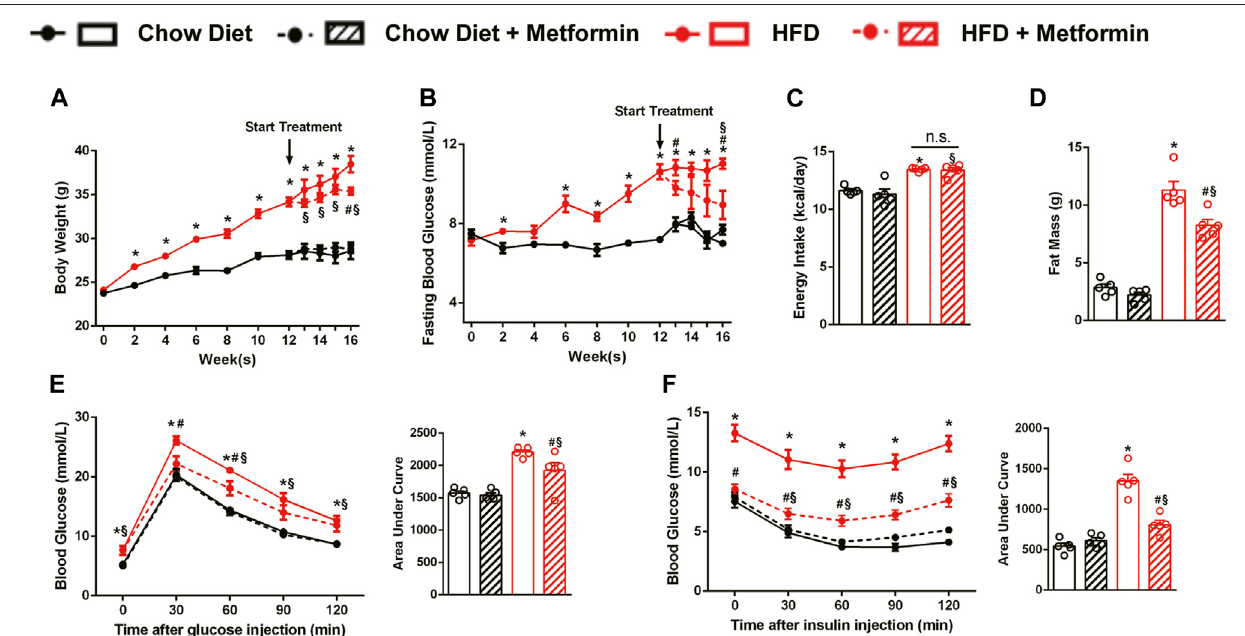
FIGURE 1 | Metformin improves obesity and glucose metabolic disordersinDIOmice. C57BL/6Jmice weretreated witheithermetformin ordrinkingwater ascontrol for4weeksafter a12-weeksdietintervention.InDIOmice,metforminsigni fi cantlyreduced (A) body weight( p ＜ 0.05), (B) fastingbloodglucose( p ＜ 0.05) butshowedno remarkableeffecton (C) energyintake( p ＞ 0.05). (D) BodyfatmassofDIOmicewasgreatlyreducedbymetformin( p ＜ 0.05). (E) TheIntraperitonealglucosetolerancetest and (F) intraperitonealinsulintolerancetestshowedthatmetforminsigni fi cantlyimprovedglucosetoleranceandinsulinsensitivity( p ＜ 0.05).Dataareshownasmean